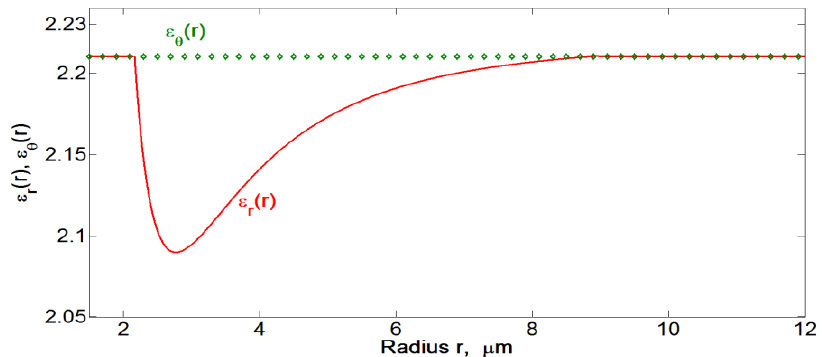
Figure 21. Radial dependence of 2 ( ) n r   m = {3,5} shown in Figure 20, with . The data correspond to the toluene dispersion of “short/thin” Au NRs in the flat cell, 𝝀 = 𝟔𝟓𝟔 𝒏𝒎 , U = 200 V f = 100 kHz, see Figure